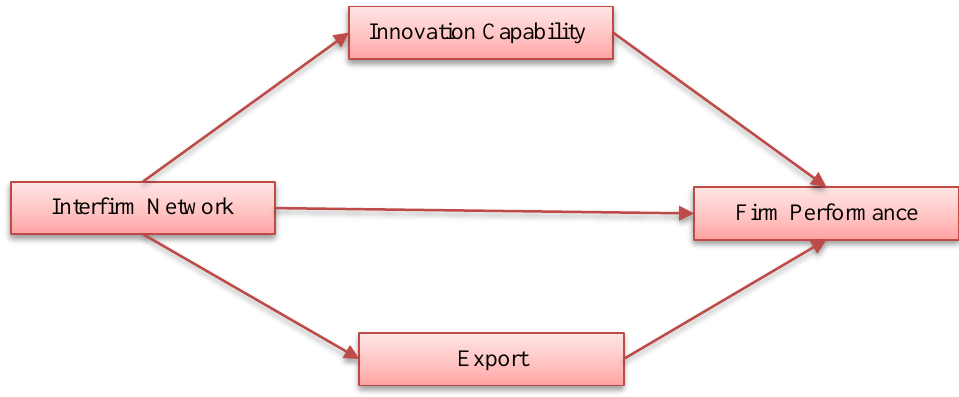
Figure 1. Interfirm Network, Innovation Capability, Export, and Firm Performance